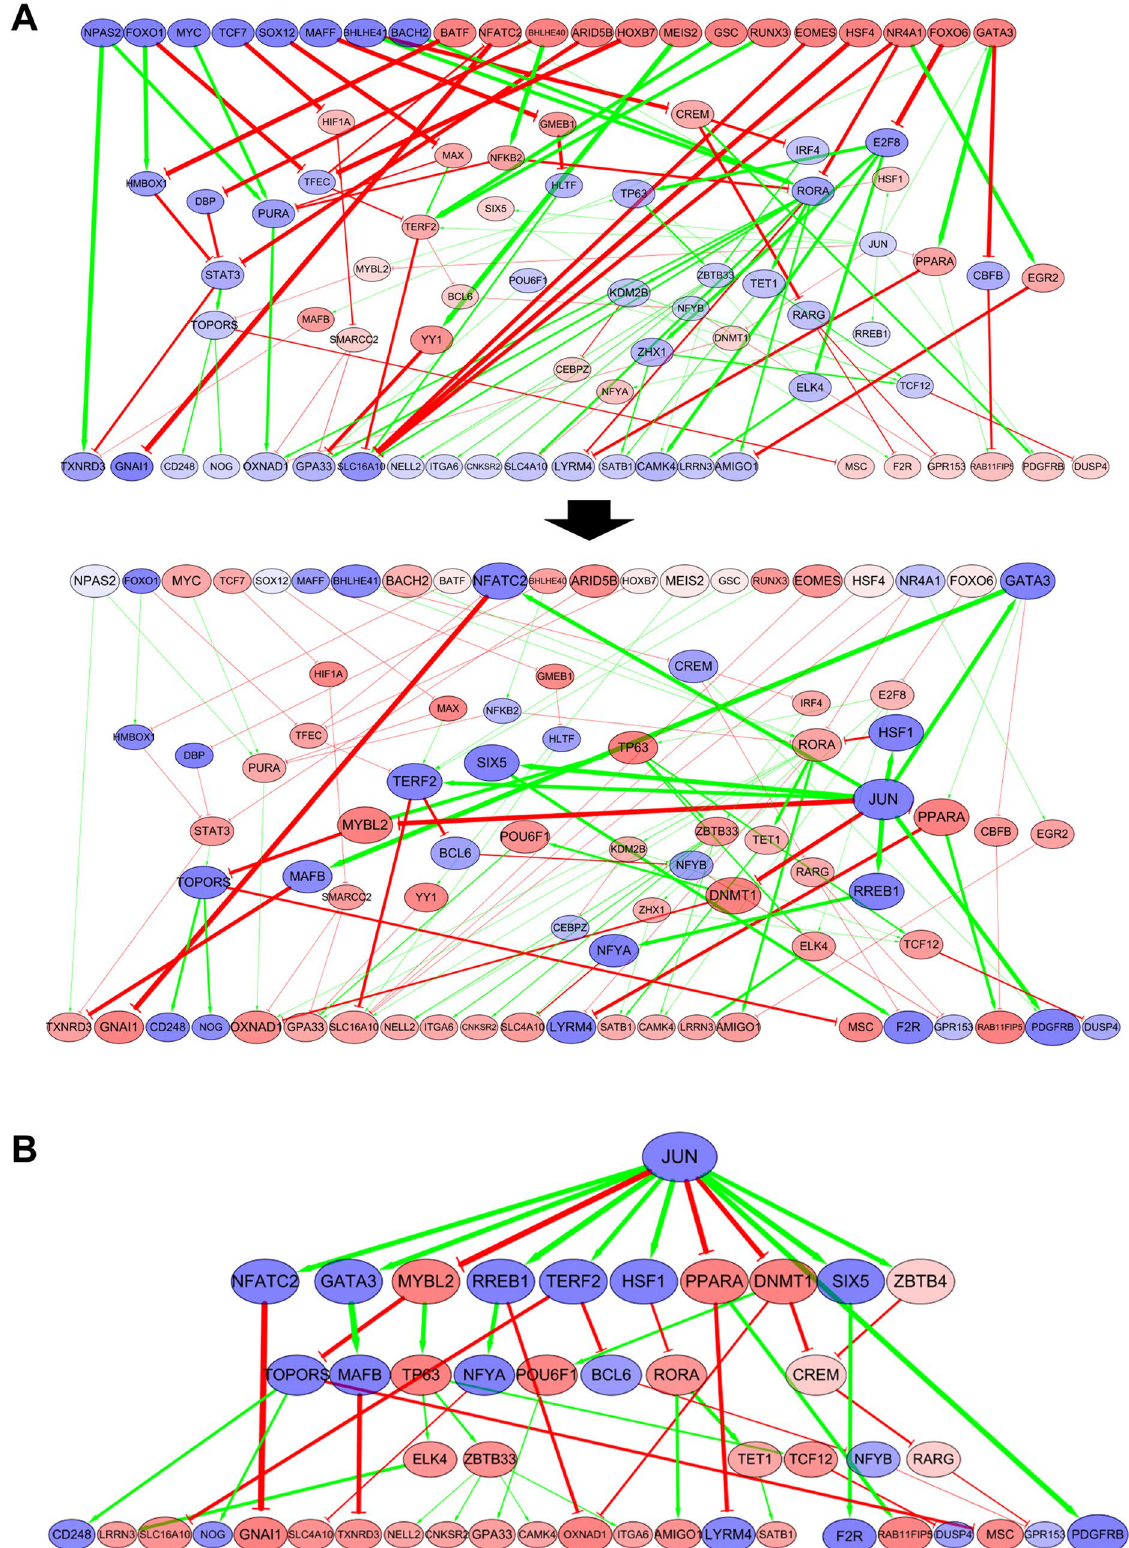
Figure 5. Subnetwork visualization. ( A ) Subnetwork showing the regulation of expression of DEG outputs by DMP inputs; 17 out of 22 DEG output nodes are reversely regulated by JUN inhibition. ( B ) A subnetwork showing the regulation of output DEGs by JUN inhibition and its downstream regulation. An increase in edge thickness and node size is based on the intensity of the signal transmitted to the DEG markers via the network. Up-regulated and down regulated genes are denoted with red and blue,